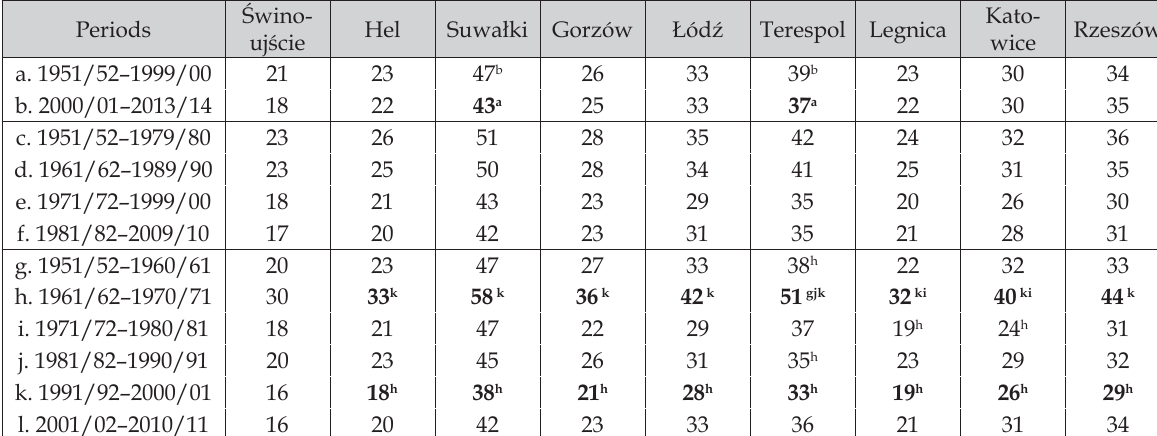
Table 2. Average number of ice days for various periods at stations representing each grid box for which circulation classification